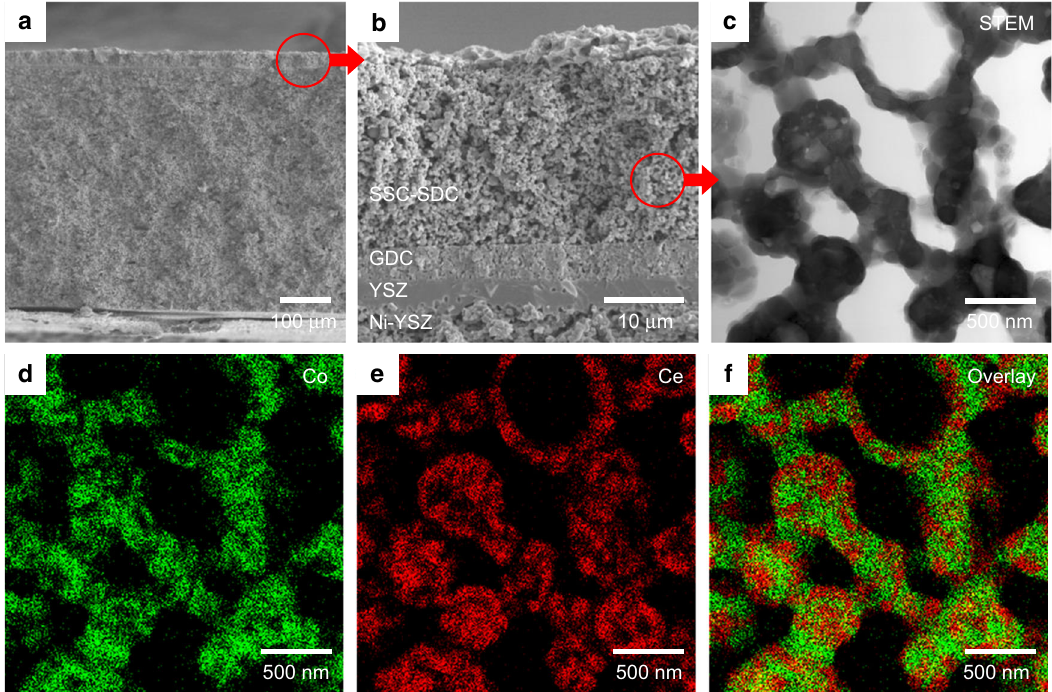
Fig. 3 Cross-sectional images of solid oxide electrolysis cell with nanocomposite electrode. a FE-SEM image of the SOEC consisting of four components, i.e., SSC-SDC(50:50) nanocomposite electrode, GDC interlayer, YSZ electrolyte, and Ni-YSZ fuel electrode. b Enlarged FE-SEM image of interfacial structure between each component. c STEM image, d , e EDX mappings of Co and Ce, and f overlay image of Co and Ce mappings of SSC-SDC(50:50) nanocomposite electrode.